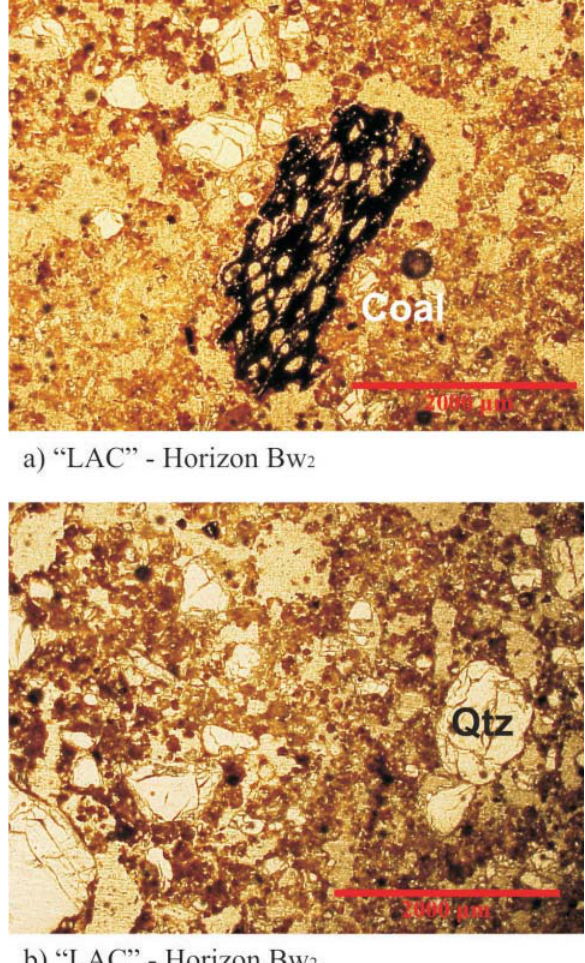
Figure 6. Photomicrographs (under ambient light) of “LAC” horizons: (a) Bw horizon of the LAC, with coal; (b) porphyric-enaulic zone with a dense microgranulated microstructure and granulated